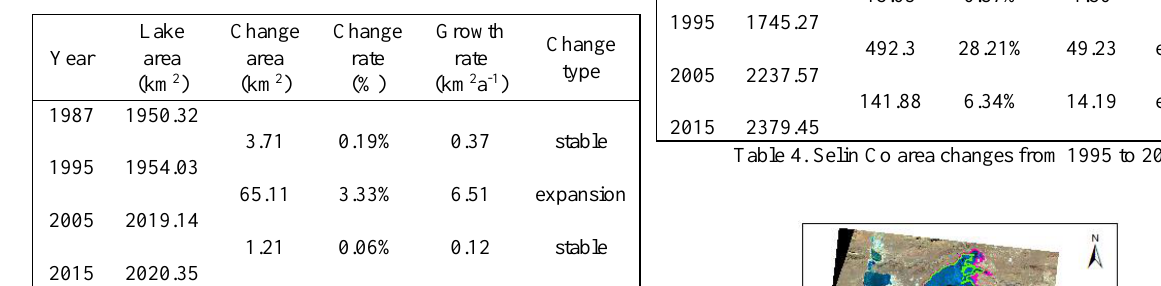
Table 3. Nam Co area changes from 1995 to 2015